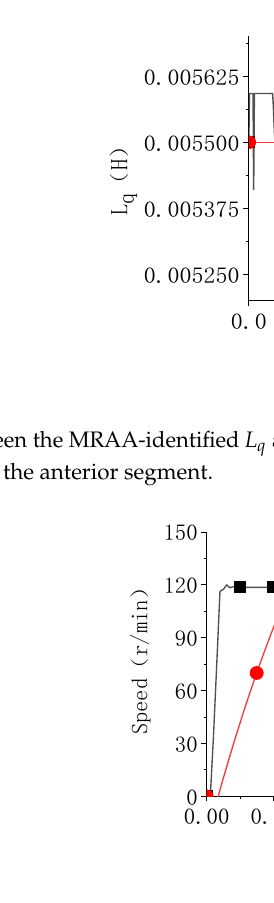
Figure 11. Comparison between the MRAA-identified L d and the actual L d . ( a ) Comparison of L d and ( b ) the local magnification of the anterior segment.